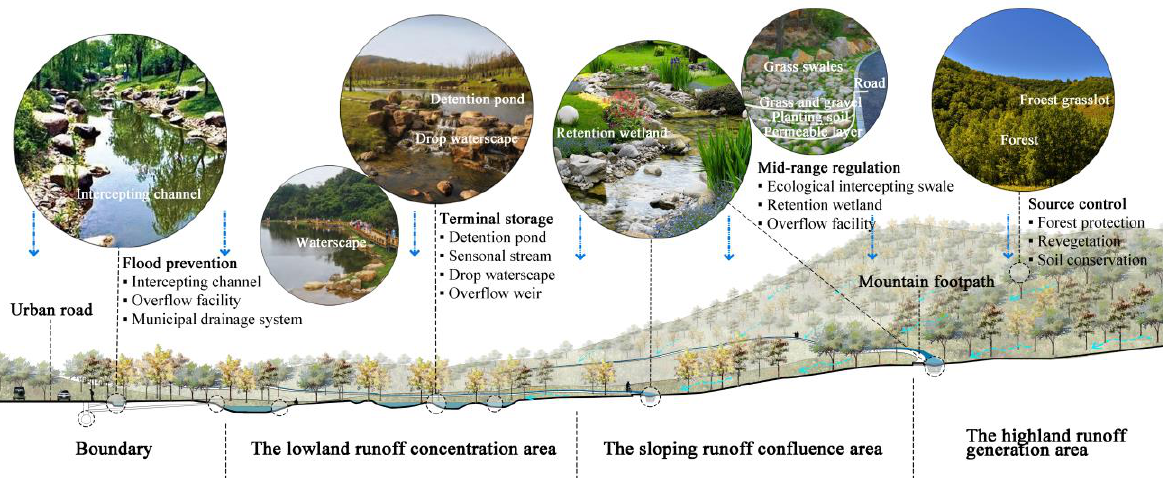
Figure 3. Schematic of hydrological multi-level control strategies for the mountain park.